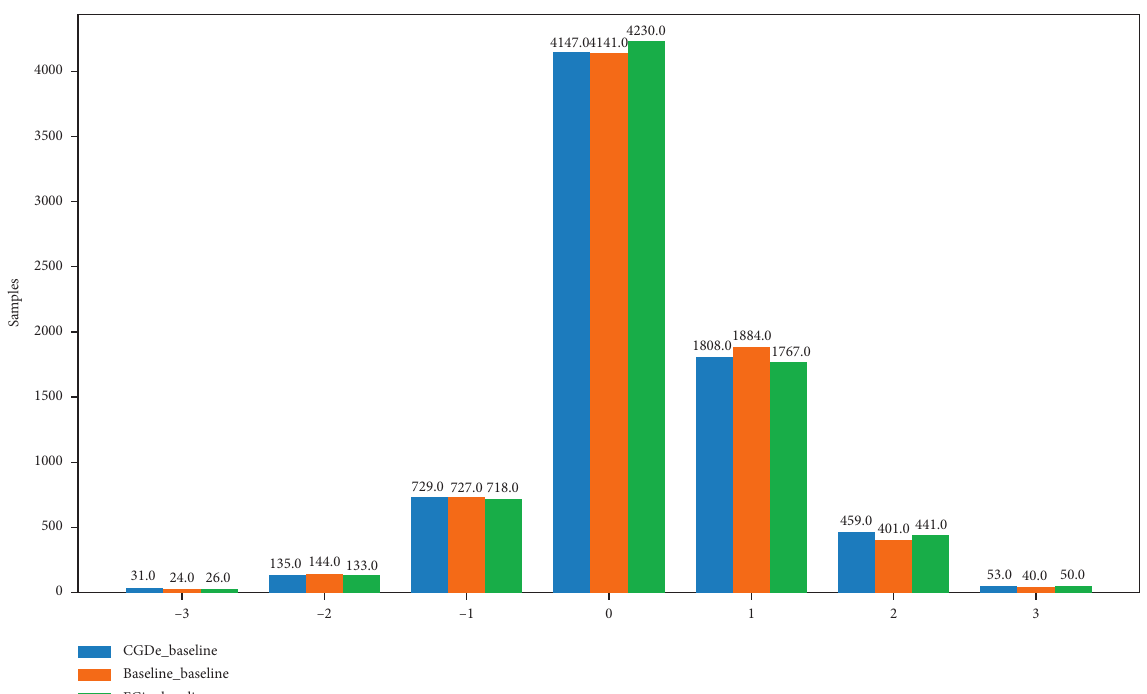
Figure 10: Number of predictions minus number of gold sentences (with two strategies).